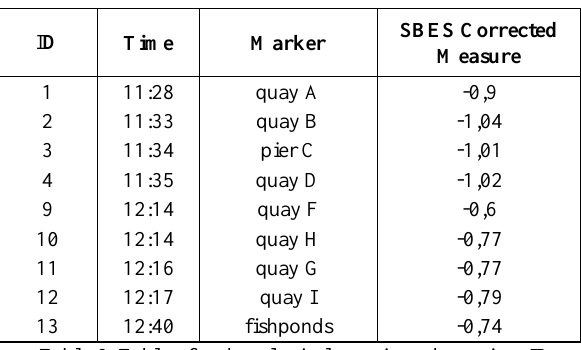
Topographic profile topographic profiles along the